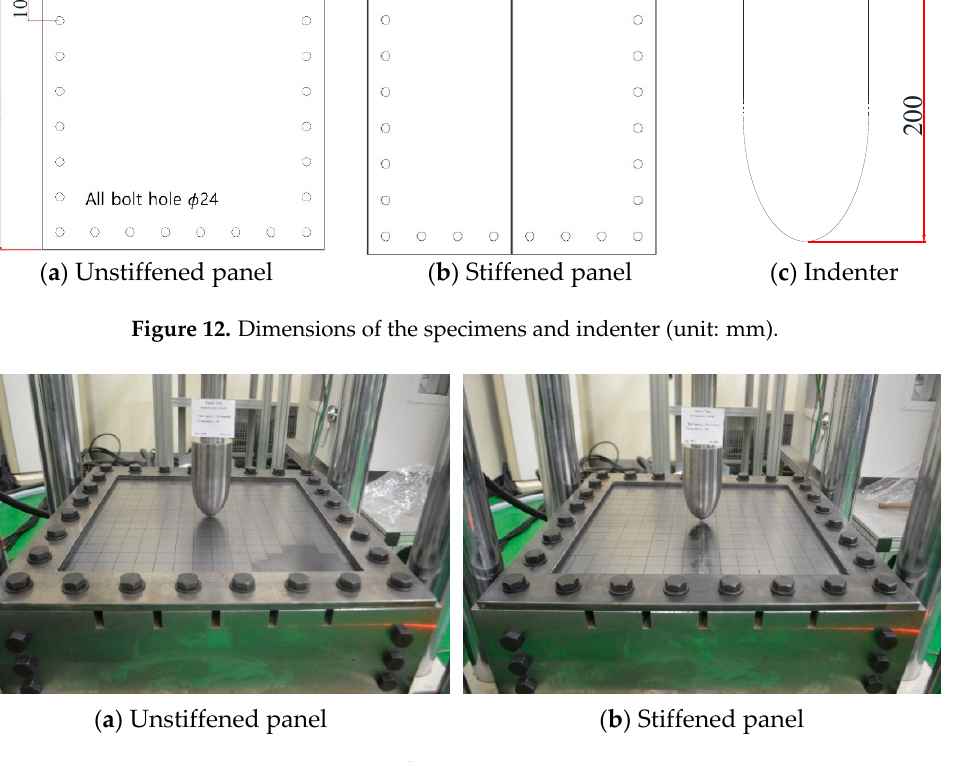
Figure 13. Images of the punching test specimens.